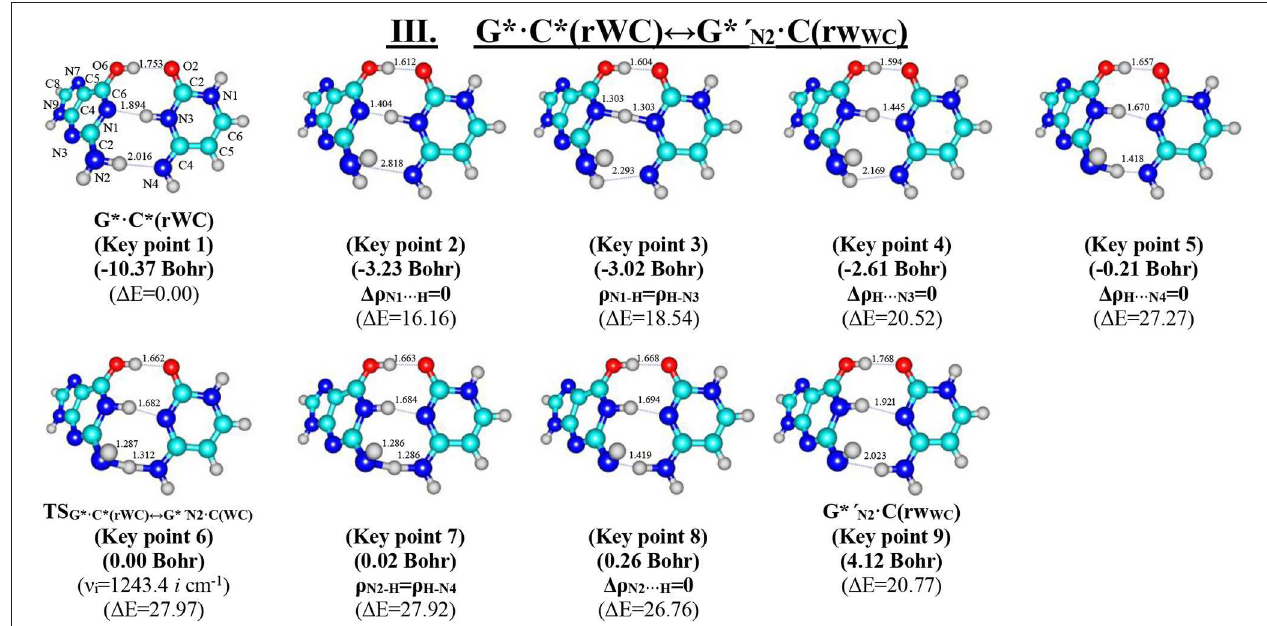
C(rWC) tautomerisation via the DPT along the IRC C*(rWC) G* ′ N2 · · ↔